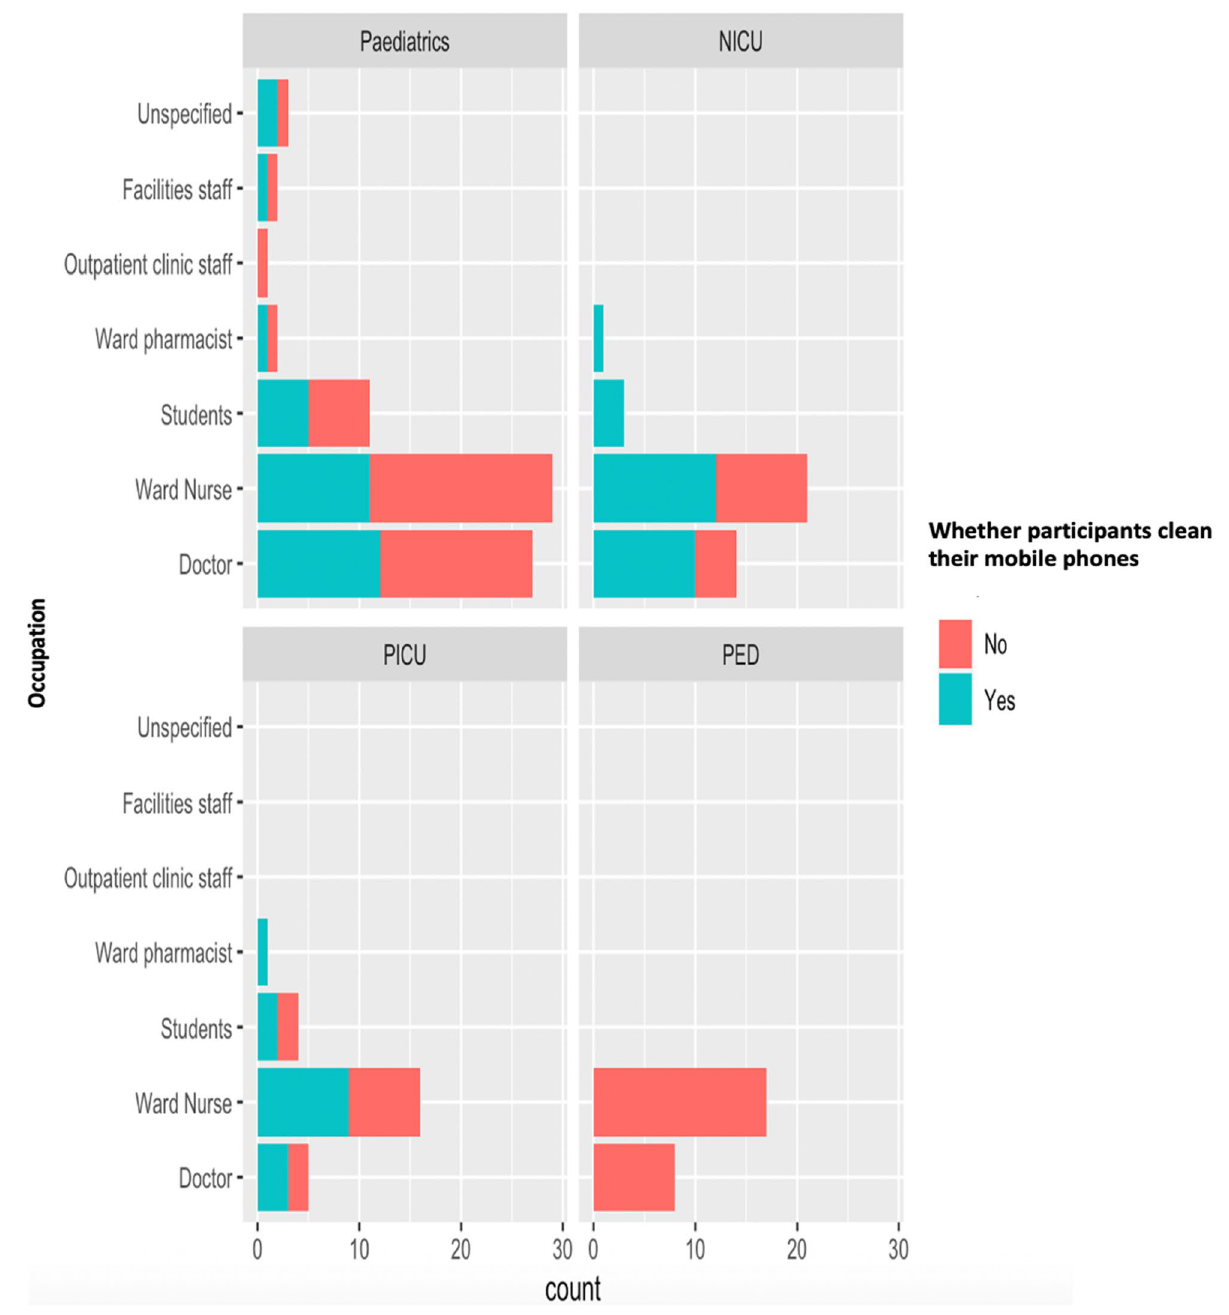
Figure 3. Mobile phone sanitisation and staff role across four different hospital wards (General Paediatrics, Neonatal Intensive Care Unit, Paediatric Intensive Care Unit, Paediatric Emergency